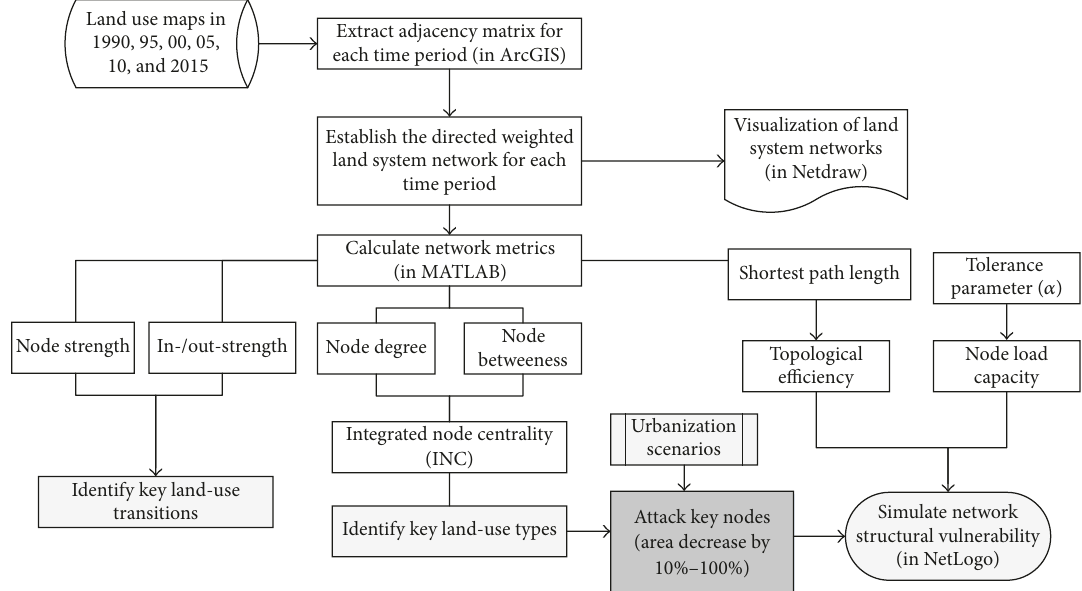
Figure 1: The analysis process of topological characteristics and structural vulnerability of land